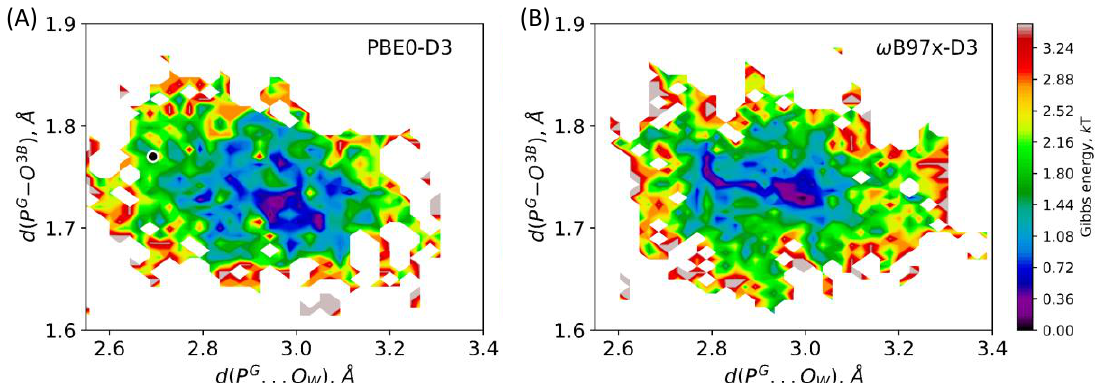
Figure 3. Maps demonstrating dynamic features of ES complexes in respect of two interatomic distances, d(P G –O 3B ) and d(P G . . . O W ), calculated with the PBE0-D3 ( A ) and ω B97x-D3 ( B ) functionals in the QM/MM MD simulations. The color bar is in the k T units.